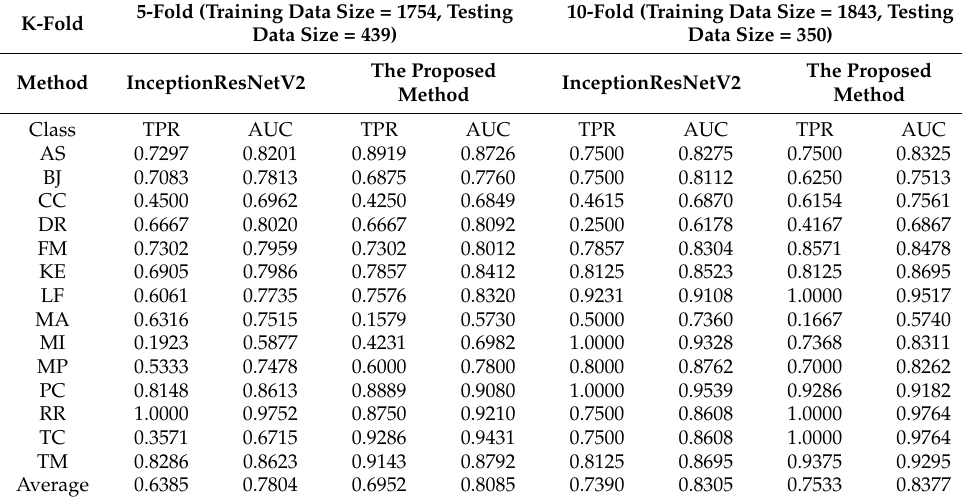
Table 5. Comparison of true positive rate (TPR) and area under the curve (AUC) between the proposed method and InceptionResNetV2 in each class. K-Fold